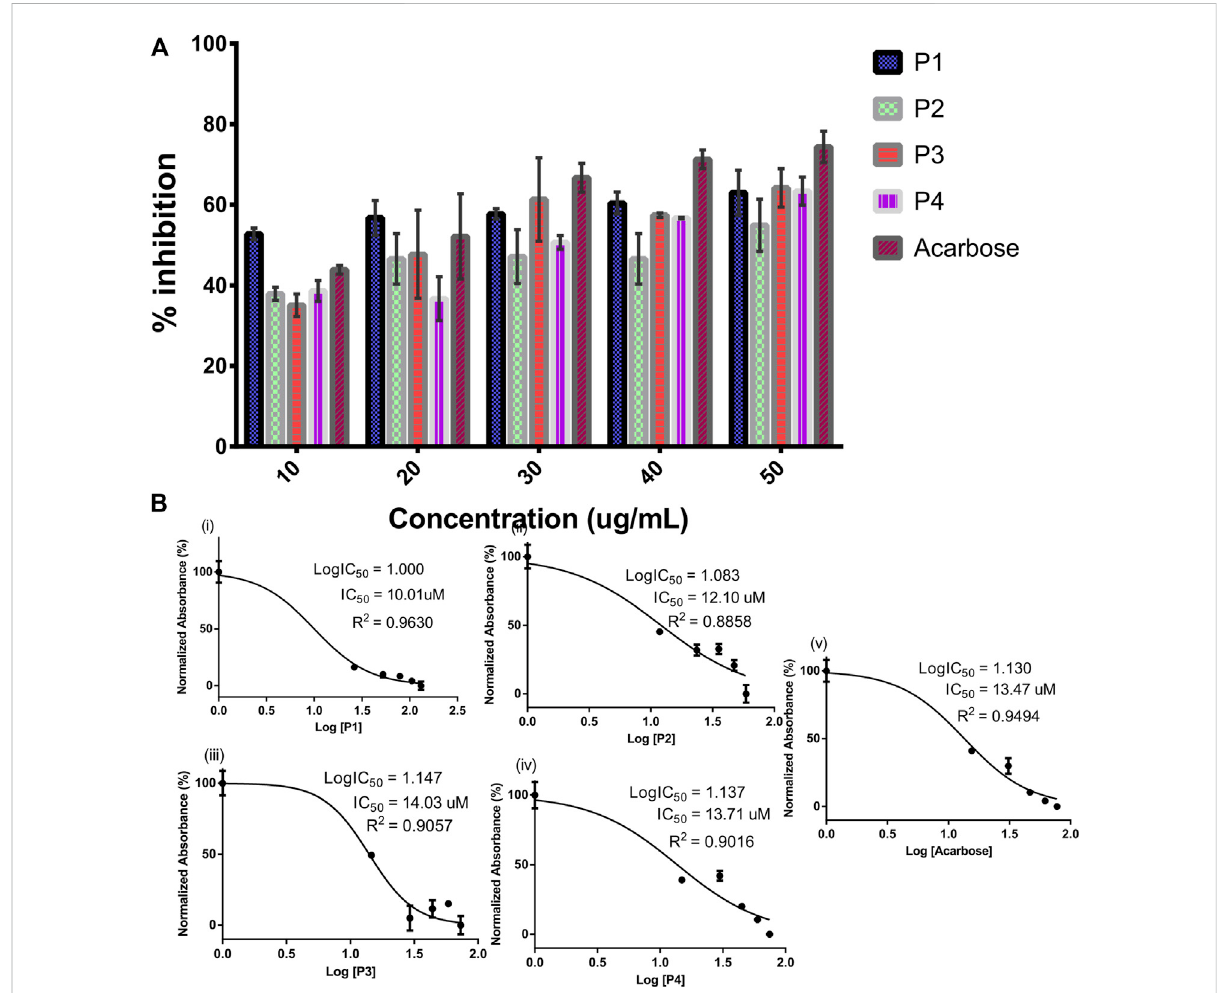
FIGURE 3 Inhibitory activity of steroidal pregnane compounds (P1 – P4) and acarbose against alpha-amylase. Percentage inhibitory activity (A) and half- maximal inhibitory concentrations (IC50) (B)